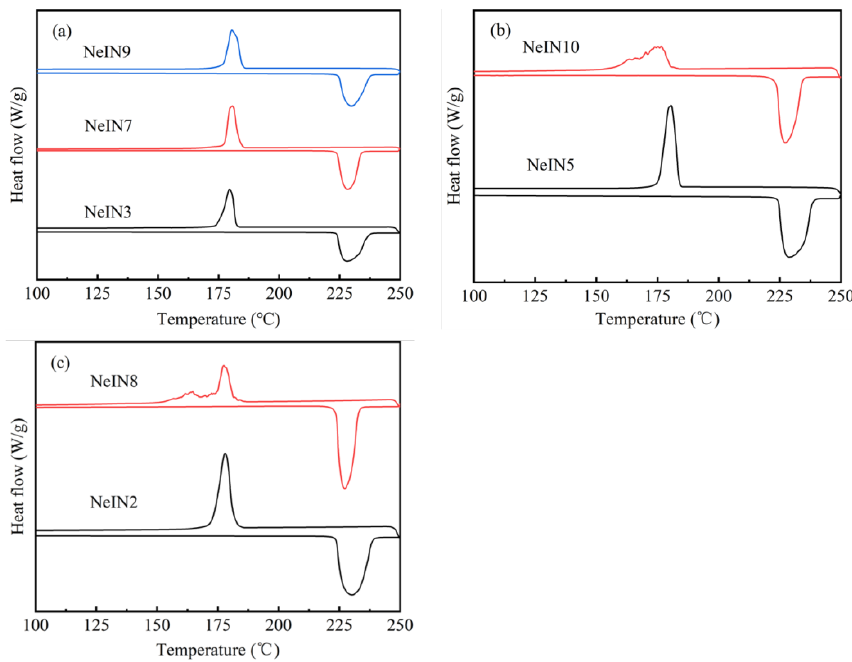
Figure 8. DSC curves of the nanocapsules with various conditions: ( a ) NeIN3, NeIN7 and NeIN9; ( b ) NeIN5 and NeIN10; ( c ) NeIN2 and NeIN8